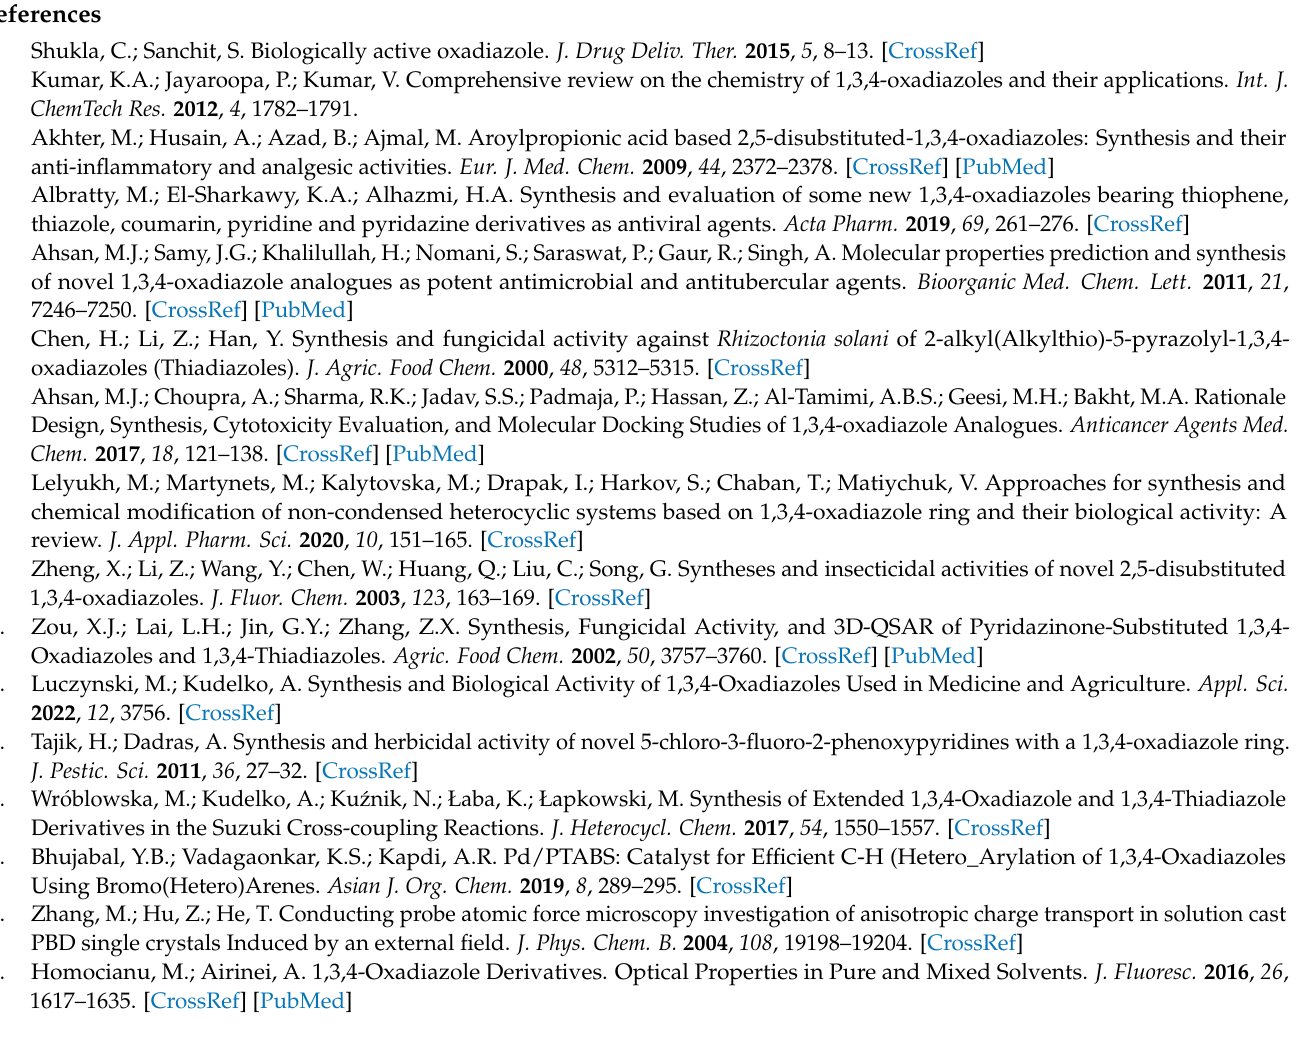
Figure S30: 13 C NMR spectra (100 MHz, CDCl 3 ) of Tetraisopropyl 2,2 (cid:48) ,2 (cid:48)(cid:48) ,2 (cid:48)(cid:48)(cid:48) -(((1,3,4-oxadiazole-2,5- diyl)bis(butane-4,1-diyl))bis(azanetriyl))tetraacetate ( 6e ); Figure S31: 1 H NMR spectra (400 MHz, dmso) of 2,2 (cid:48) ,2 (cid:48)(cid:48) ,2 (cid:48)(cid:48)(cid:48) -(((1,3,4-oxadiazole-2,5-diyl)bis(methylene))bis(azanetriyl))tetraacetic acid ( 7b ); Figure S32: 13 C NMR spectra (400 MHz, dmso) of 2,2 (cid:48) ,2 (cid:48)(cid:48) ,2 (cid:48)(cid:48)(cid:48) -(((1,3,4-oxadiazole-2,5-diyl)bis(methylen- e))bis(azanetriyl))tetraacetic acid ( 7b ); Figure S33: 1 H NMR spectra (100 MHz, dmso) of 2,2 (cid:48) ,2 (cid:48)(cid:48) ,2 (cid:48)(cid:48)(cid:48) - (((1,3,4-oxadiazole-2,5-diyl)bis(propane-3,1-diyl))bis(azanetriyl))tetraacetic acid ( 7d ); Figure S34: 13 C NMR spectra (400 MHz, dmso) of 2,2 (cid:48) ,2 (cid:48)(cid:48) ,2 (cid:48)(cid:48)(cid:48) -(((1,3,4-oxadiazole-2,5-diyl)bis(propane-3,1-diyl))bis(aza- netriyl))tetraacetic acid ( 7d